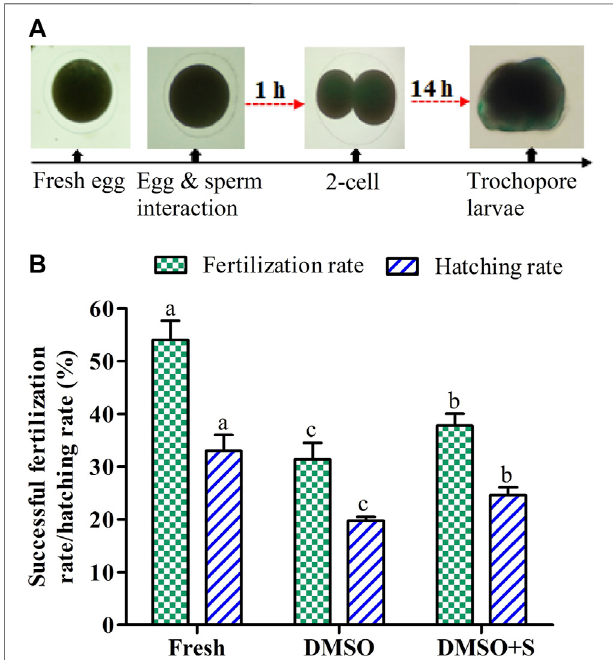
FIGURE 8 | Effects of sucrose on the fertilization and hatching capacity ofpost-thawspermofPaci fi cabalone( n =3). (A) Two-celldivisionoccurredat 1 hour post-fertilization and trochophore larvae hatched out at 14 h post- fertilization. (B) Fertility and hatchability of Paci fi c abalone sperm cryopreserved using 3% sucrose combined with 8% DMSO. DMSO: 8% dimethyl sulfoxide, DMSO + S: 8% dimethyl sulfoxide (DMSO) combined with 3% sucrose (S). Signi fi cantly different levels ( p < 0.05) aredenoted bydifferent letters.